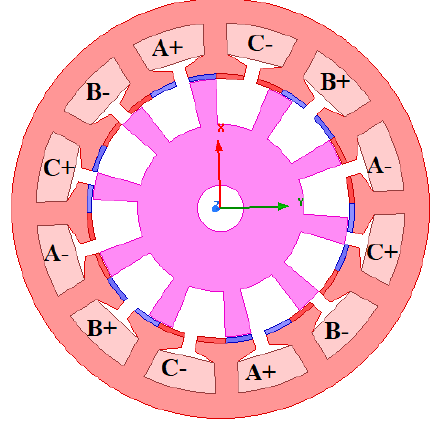
Figure 14. Configuration of a 12-stator-slot/10-pole-rotor of FRM [32].